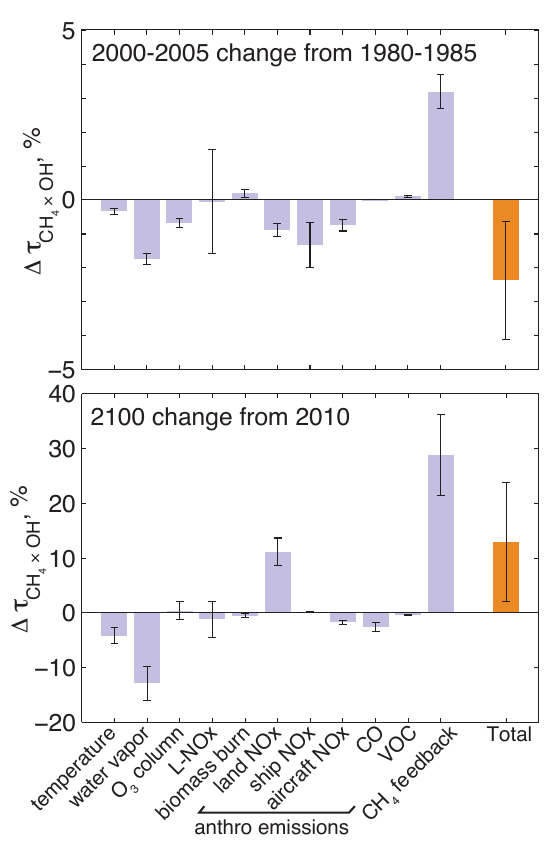
Fig. 6. Contribution of emissions and chemistry-climate interac- tions to changes in τ CH from 1980 to 2005 (top) and from 4 × OH 2010 to 2100 (bottom). Components and their uncertainties are de- rived from adopted parameters in Table 2 and forcing variables in Table 3. Uncertainties (vertical bars) are standard deviations from 10 5 monte carlo integrations. Changes are averaged over the 5 years at the beginning and end of the historical reconstruction due to in- terannual variability. Note the different vertical